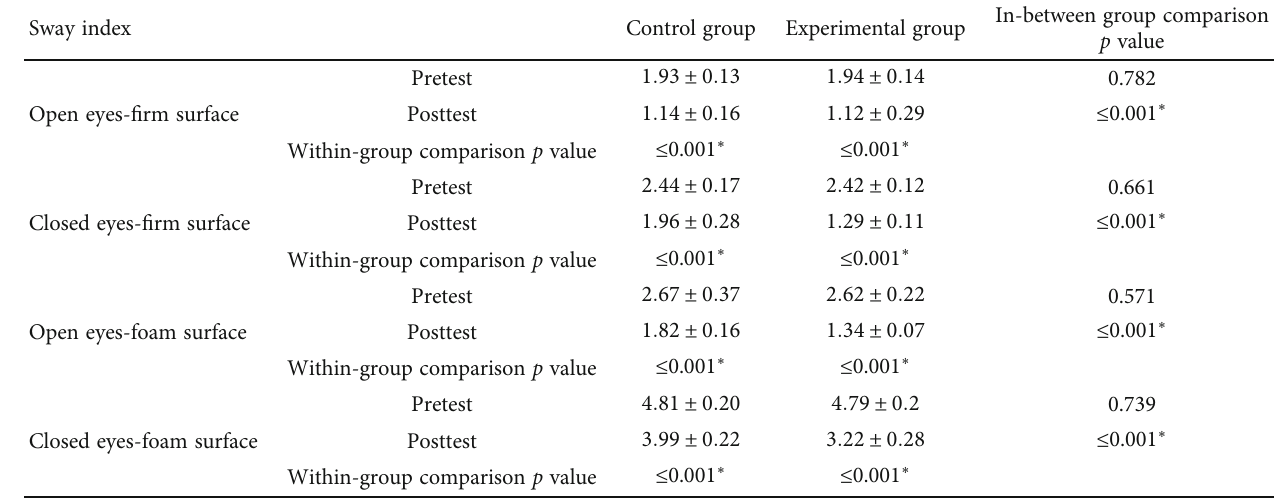
Table 2: Sway index in open eyes- fi rm surface, closed eyes- fi rm surface, open eyes-foam surface, and closed eyes-foam surface within and in-between groups.